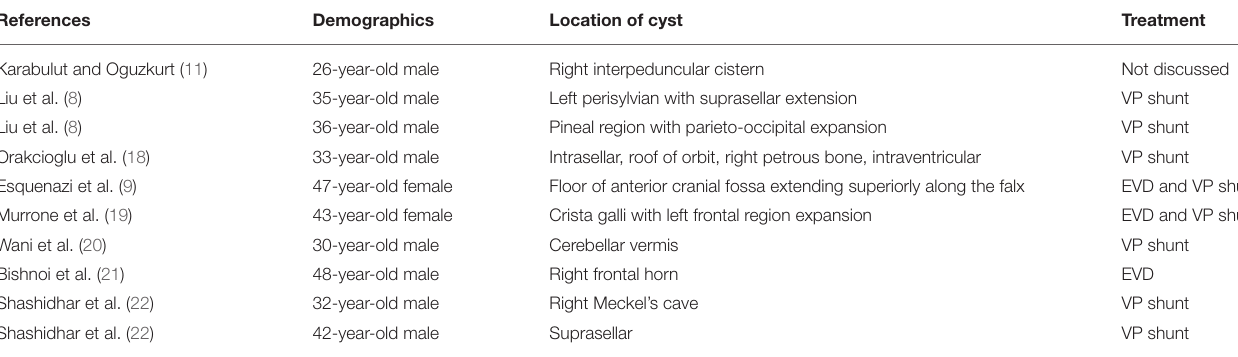
TABLE 1 | Details of literature review of patients who presented with hydrocephalus post intracranial dermoid cyst